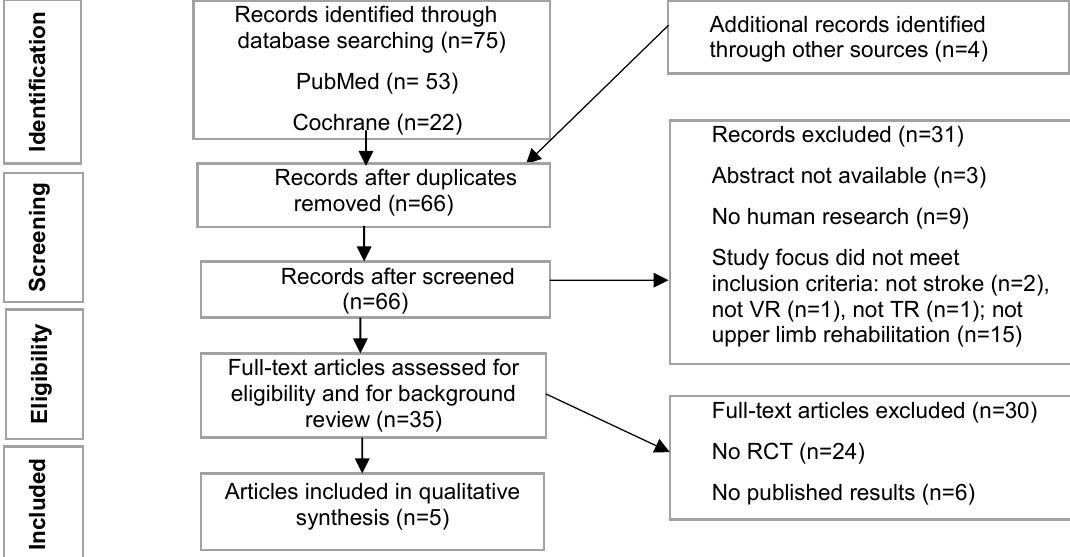
Note. This diagram shows the process for identifying and screening the articles for inclusion and